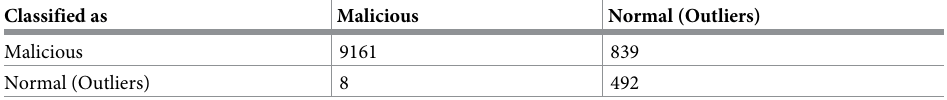
Table 7. Confusion matrix for outlier detection during one-class SVM training—Sperotto’s dataset.